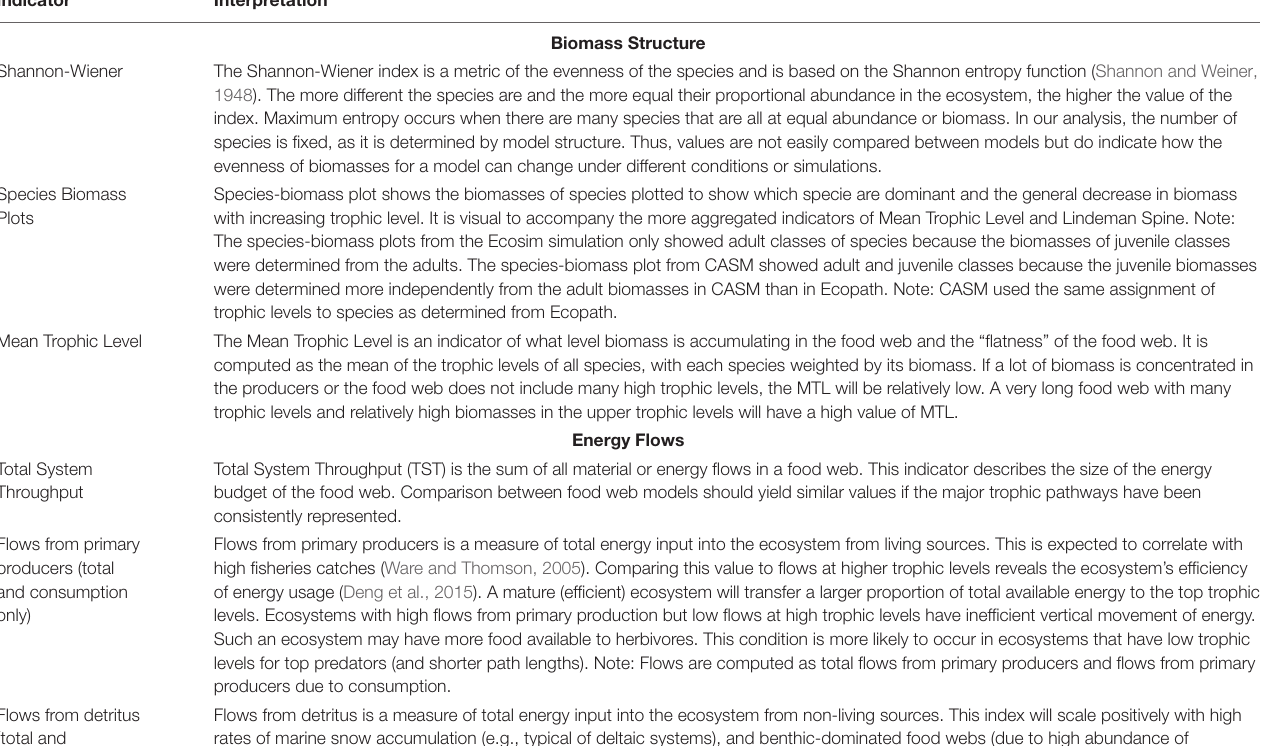
TABLE 1 | The indicators and their interpretation derived from the calibration simulations of Ecopath and CASM for the Barataria Bay. Indicator